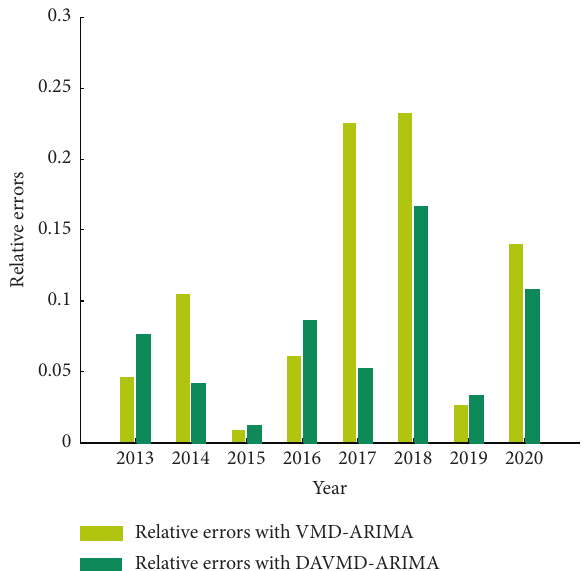
Figure 3: The relative errors for China’s birth population pre- diction of VMD-ARIMA and DAVMD-ARIMA.